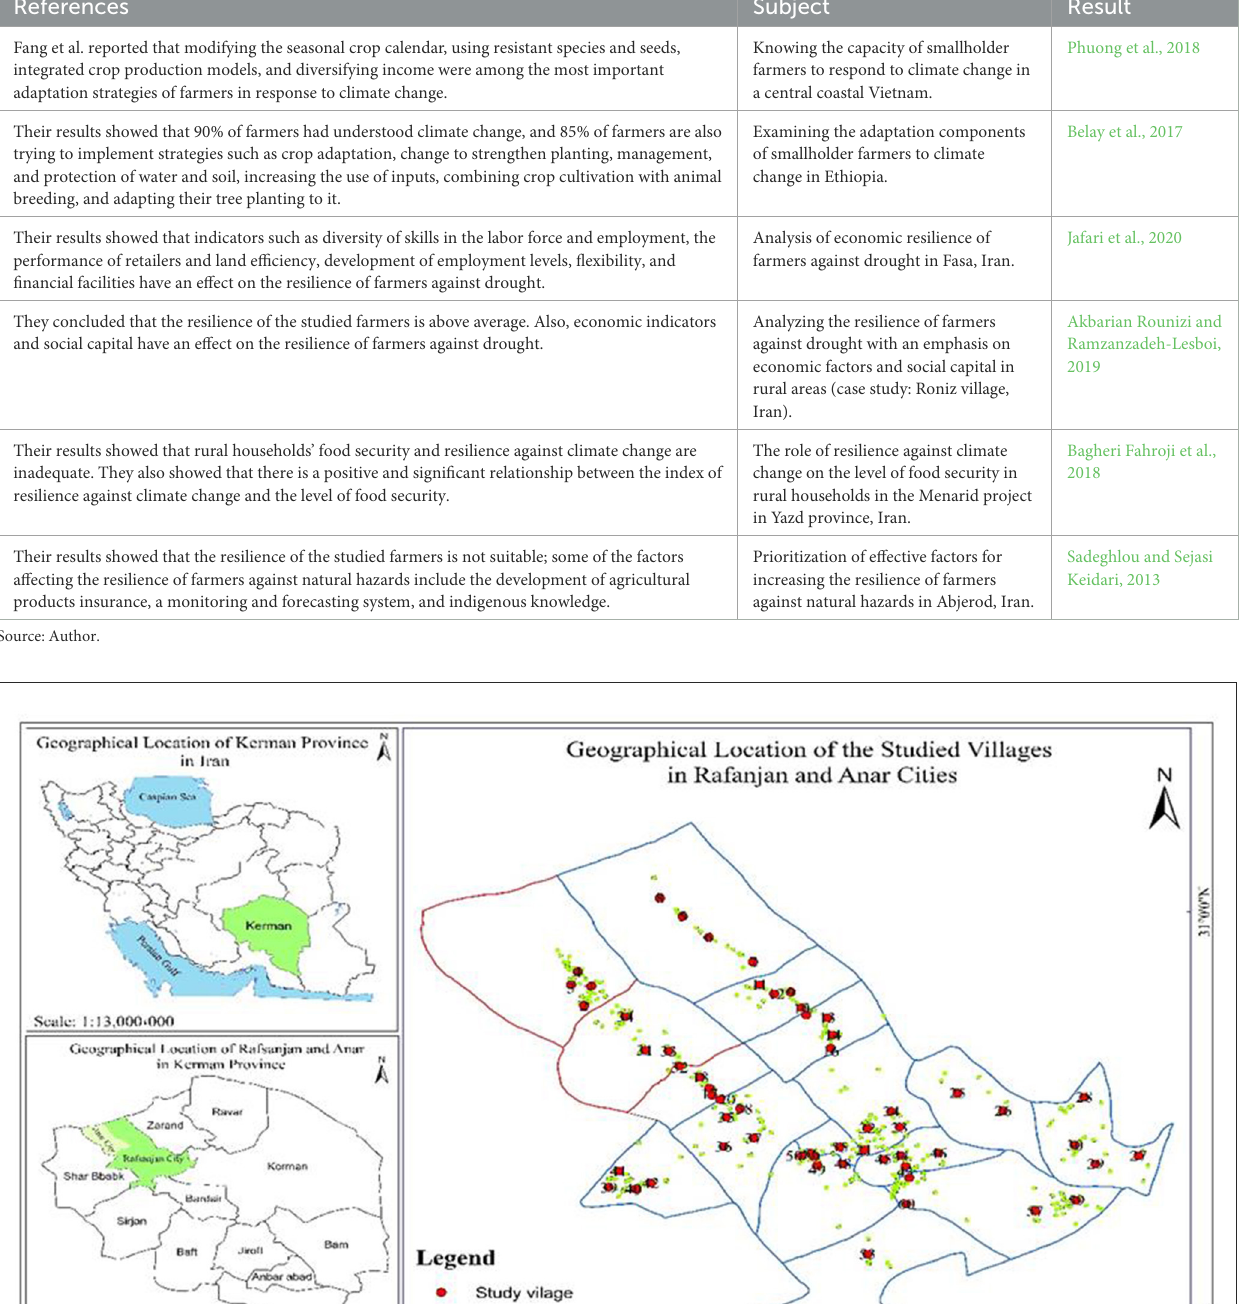
were then randomly selected in each class (map 2). Next, Cochran’s formula was used to determine the sample size of 588 users among the 27,860 users (pistachio farmers)